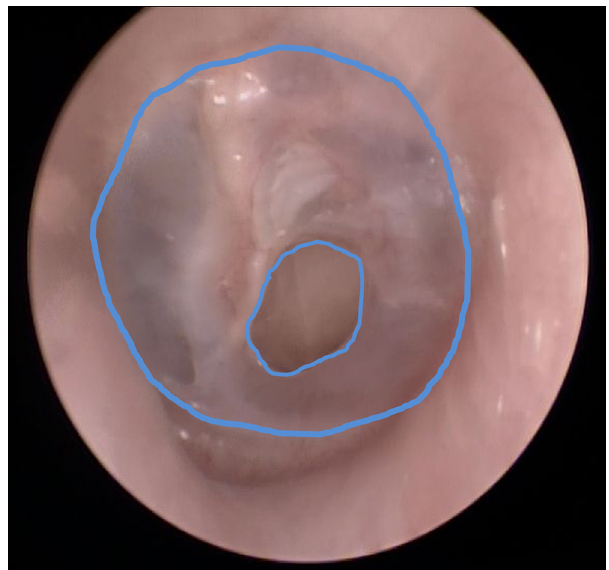
Figure 1 Image obtained through circumscription of the tym- panic membrane and of its